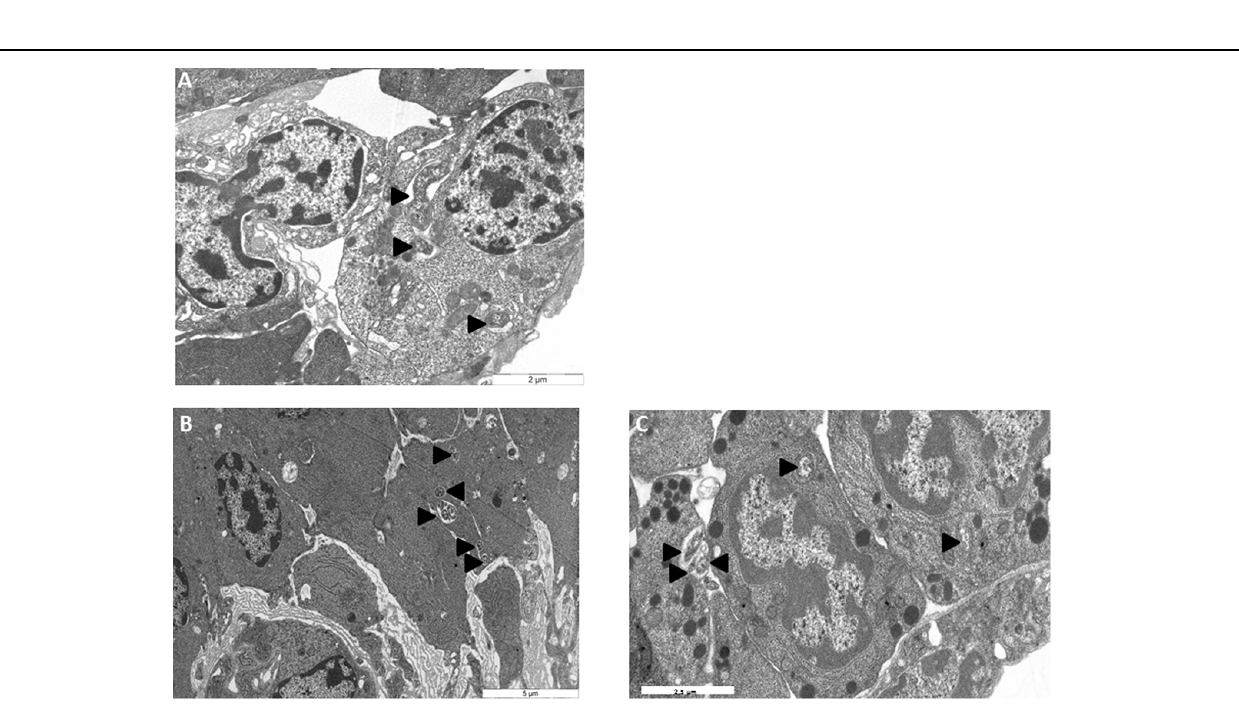
FIGURE 4 | Transmission electron microscopy observations of asymbiotic HO grafted in symbiotic animals (A) 30 days post transplantation (B,C) 60 days post transplantation. H, hemocytes (cid:2) Wolbachia.